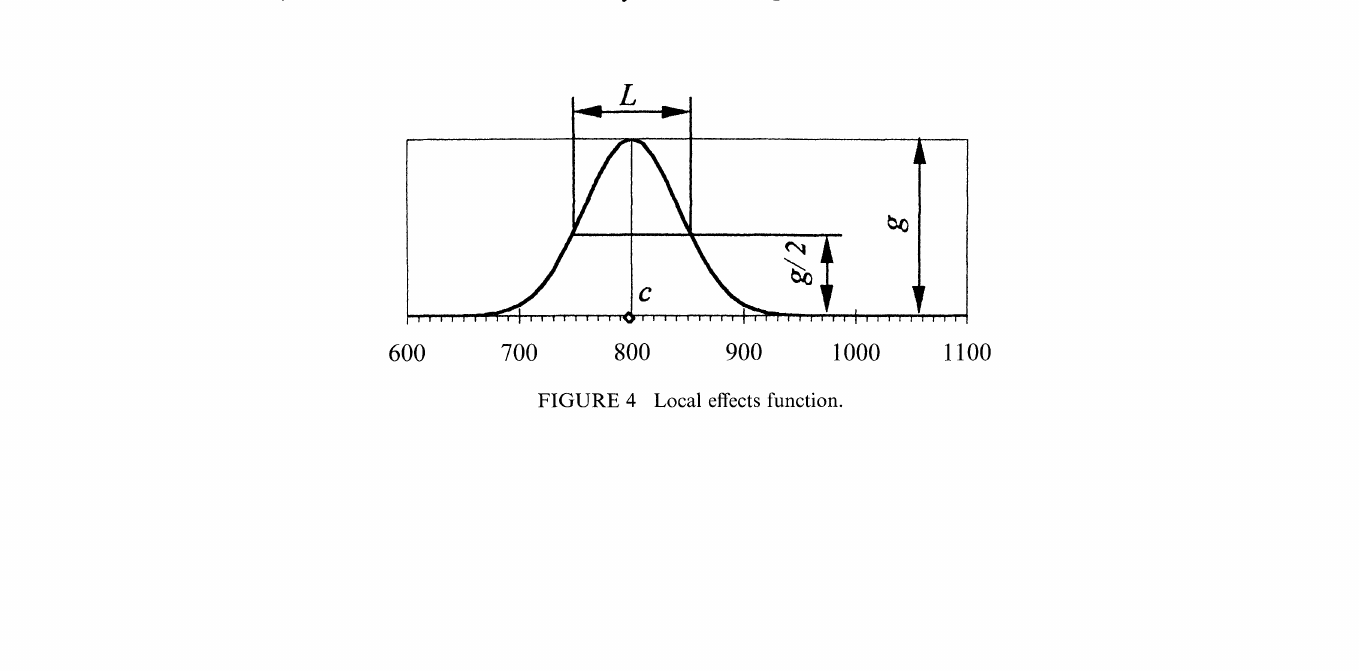
FIGURE 4 Local effects